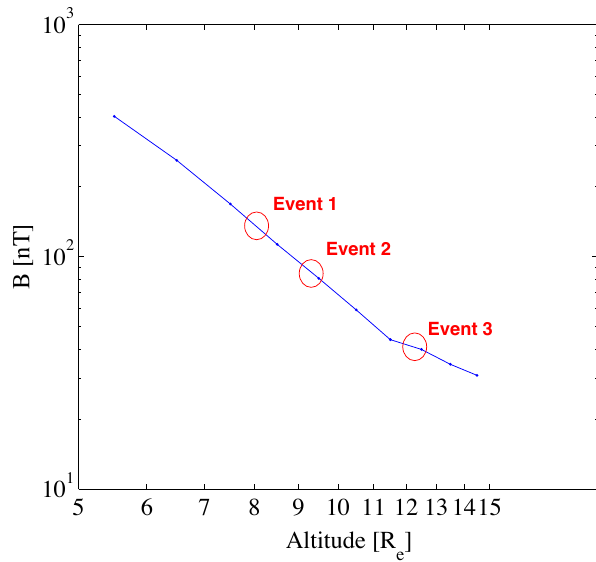
Fig. 1. The average magnetic field magnitude as a function of al- titude (logarithmic scale) for our data sets. The red circles corre- sponds to the regions where the heating events take